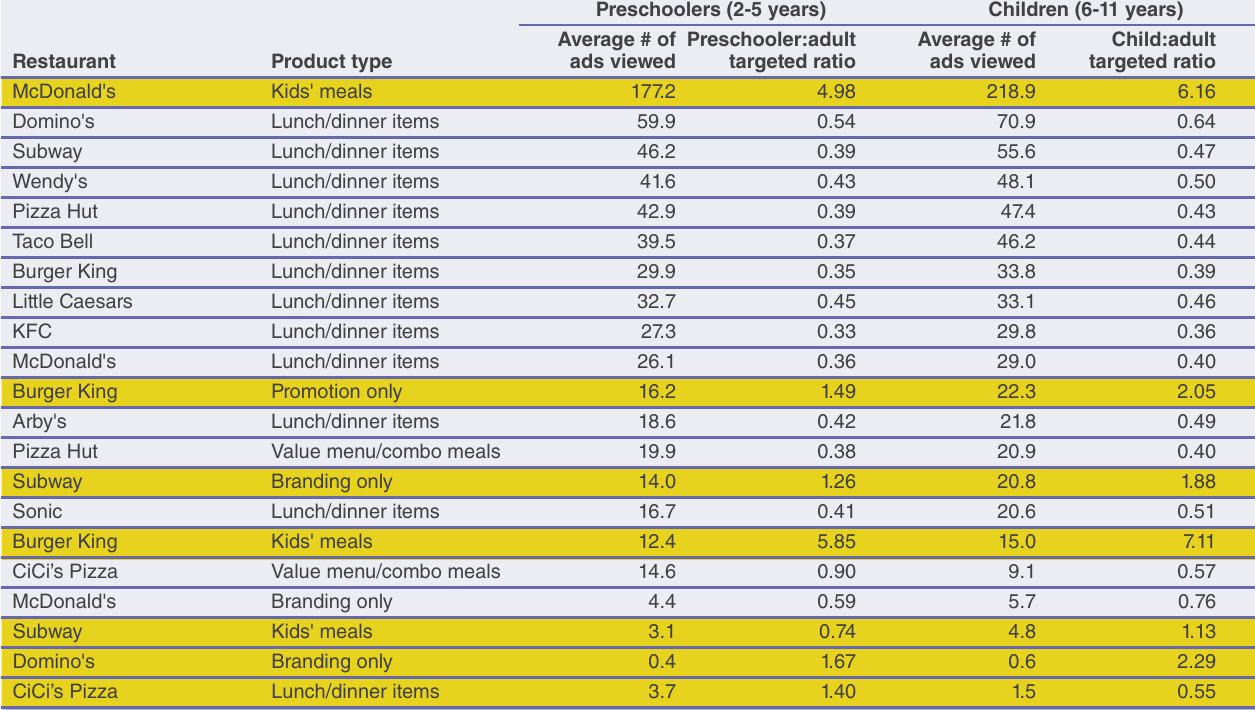
Table 18. Restaurant and product types advertised most often to preschoolers and